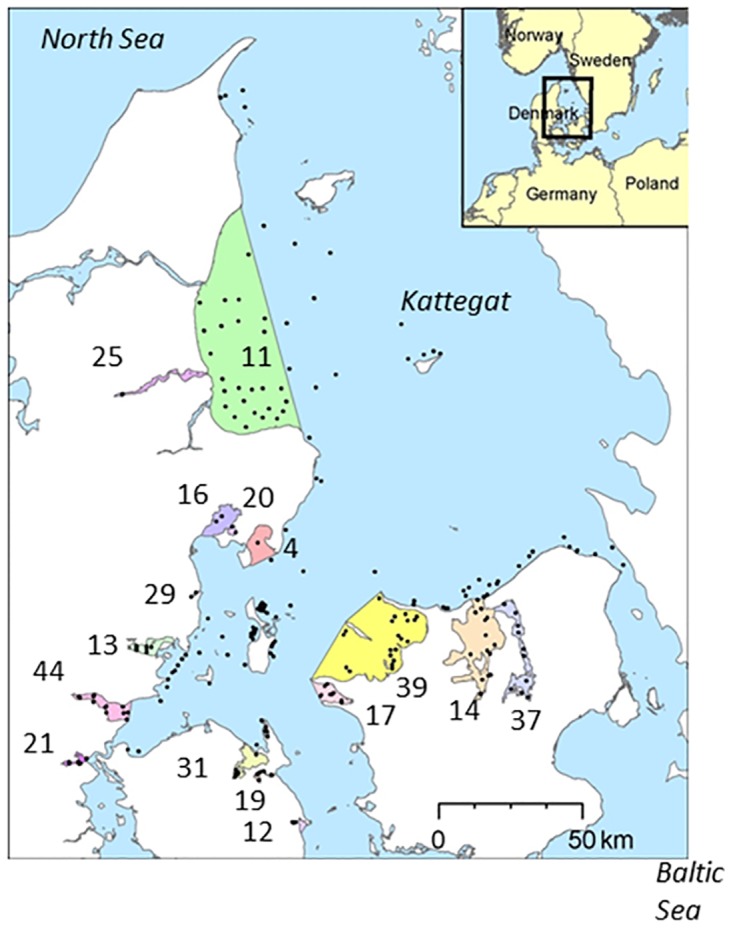
Map over the investigation area showing locations of 16 estuaries with areas indicated by different colors and id numbers as in Table 1.Open sea is indicated by blue color and the 242 sampling sites by black dots. Copyright on the base map by the Danish Geodata Agency.